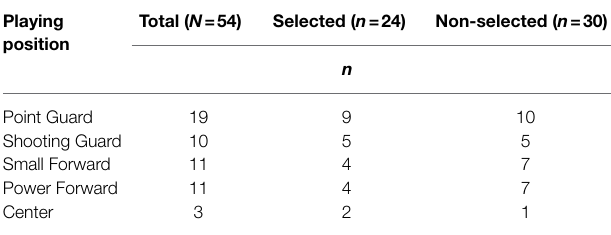
TABLE 1 | Total number of players at each playing position separated by selection status. Playing Total ( N = position